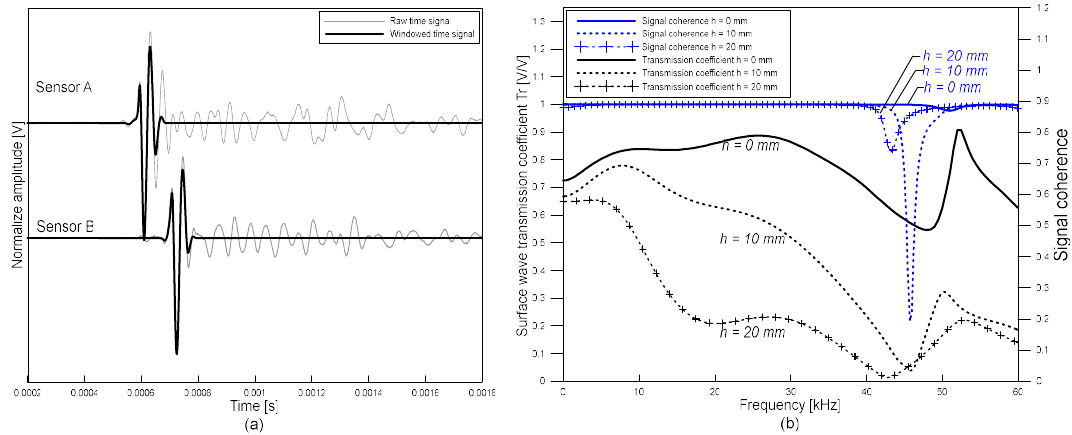
Figure 4. Typical time and frequency signals: ( a ) raw and windowed signals in the time domain, and ( b ) surface wave transmission coefficient and signal coherence in the frequency domain.